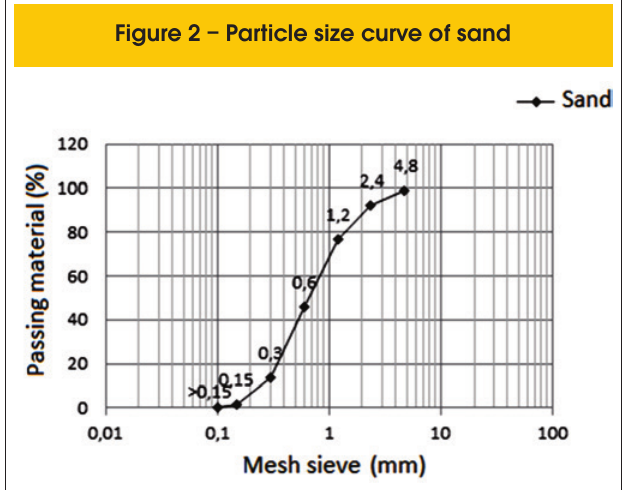
Figure 2 – Particle size curve of